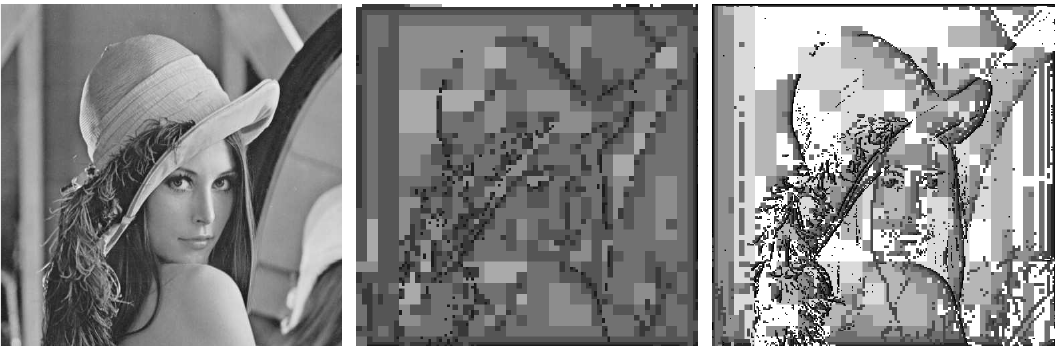
Figure 5. Computed pyramids. Left to right: original image, Daubechies wavelet levels, and levels computed by our proposal.